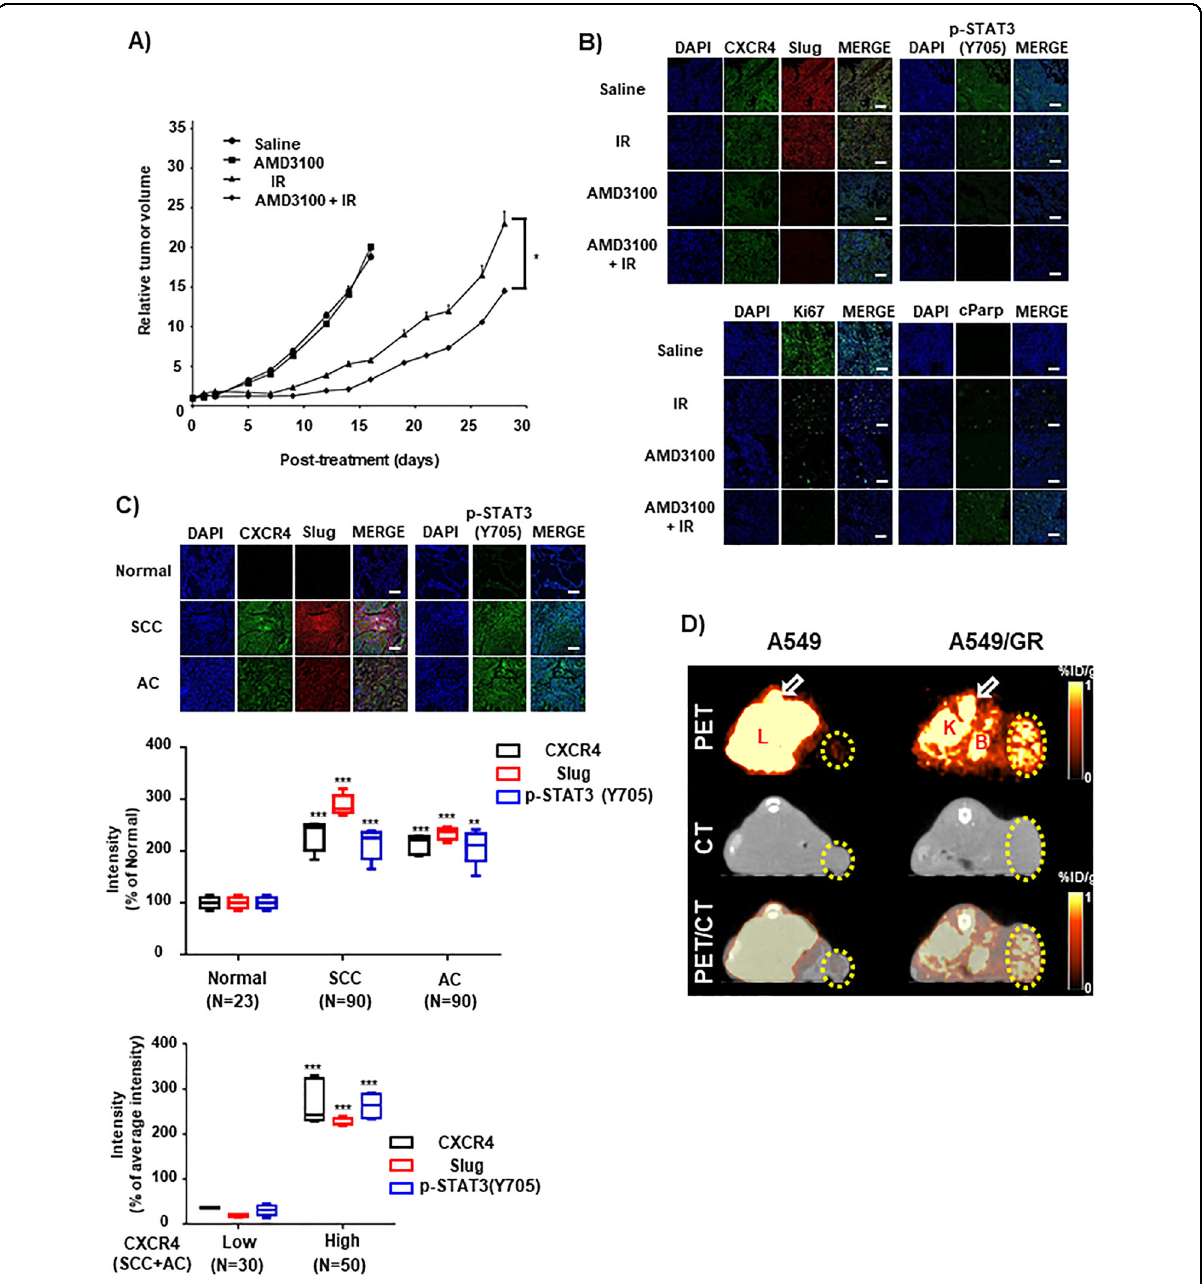
Fig. 6 Treatment of CXCR4 inhibitor enhances IR sensitivity in vivo. A AMD3100 (5 mg/kg) was released from the alzet pump implanted beneath the skin on the top of the neck of mice. IR (10 Gy) was focally exposed to the tumor when it reached to volume of 100 mm 3 . Detailed experimental procedure was described in the “ Materials and methods ” section. B Representative illustration of IHC of xenograft tissues using antibodies shown in the Figure. C IHC of NSCLC patients tissue array using antibodies is indicated in the Figure. Representative picture of the staining (in the upper part) and quanti fi cation of the fl uorescence intensity (middle and lower). Nuclei were stained with DAPI. SCC squamous cell carcinoma, AC adenocarcinoma. White bar 100 μ m. D PET/CT imaging of CXCR4 expression in subcutaneous A549 or A549/GR tumor xenografts with [ 64 Cu] AMD3100. Athymic mice bearing A549 or A549/GR xenografts on the right fl ank, were given ~11.1 MBq (300 μ Ci) of 64 Cu-labeled radiotracers via tail vein injection, and PET/CT images were acquired. The representative transaxial PET, CT, and PET/CT sections of A549 or A549/GR tumors (yellow circle) from a [ 64 Cu]AMD3100-injected mouse at 90 min postinjection. Speci fi c accumulation of radioactivity in A549/GR over A549 is apparent. The bone marrow (arrow), liver, and kidney uptake of [ 64 Cu]AMD3100 was also visualized. L liver, K kidney, B bladder. * P < 0.05.